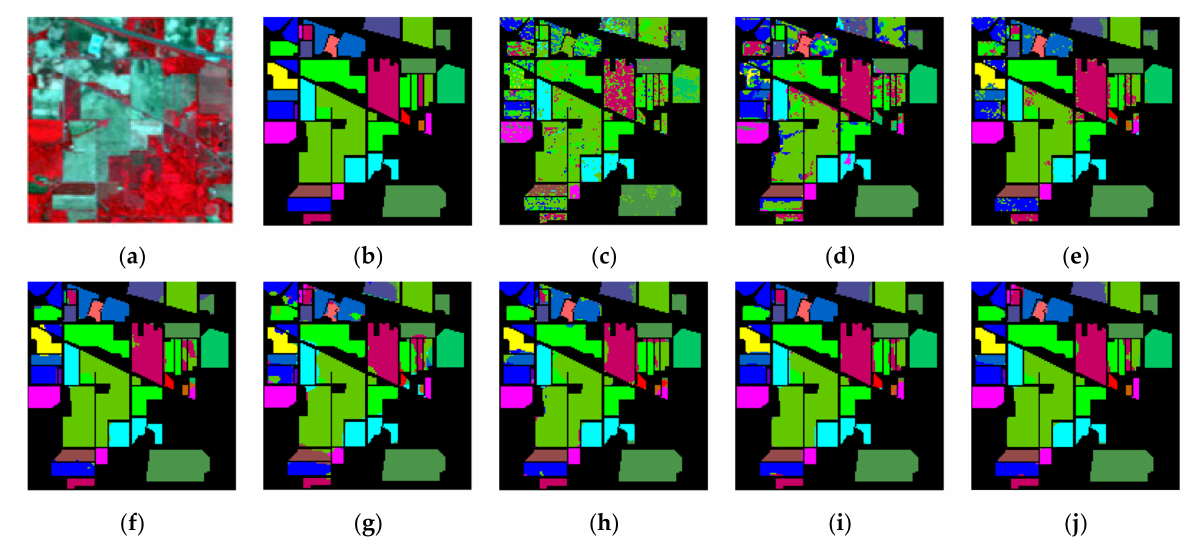
Figure 5. Classification maps for IP dataset using 5% training samples. ( a ) False-color image; ( b ) ground truth; ( c ) SVM (OA: 68.94%); ( d ) CDCNN (OA: 76.36%); ( e ) SSRN (OA: 93.56%); ( f ) FDSSC (OA: 94.81%); ( g ) HybridSN (OA: 93.20%); ( h ) DBMA (OA: 94.46%); ( i ) DBDA (OA: 97.19%); ( j ) proposed method (OA: 97.54%).